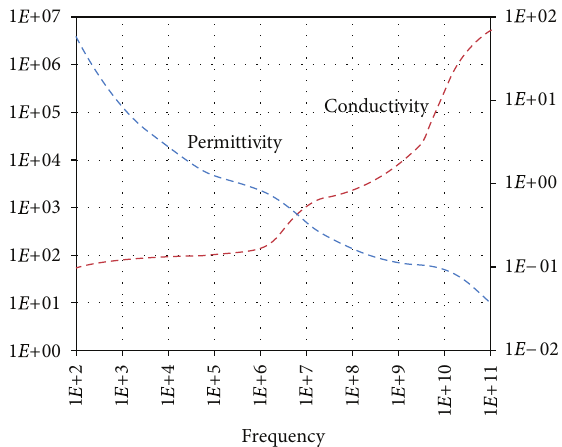
F 1: Dielectric properties spectrum of a high water content tissue [3].